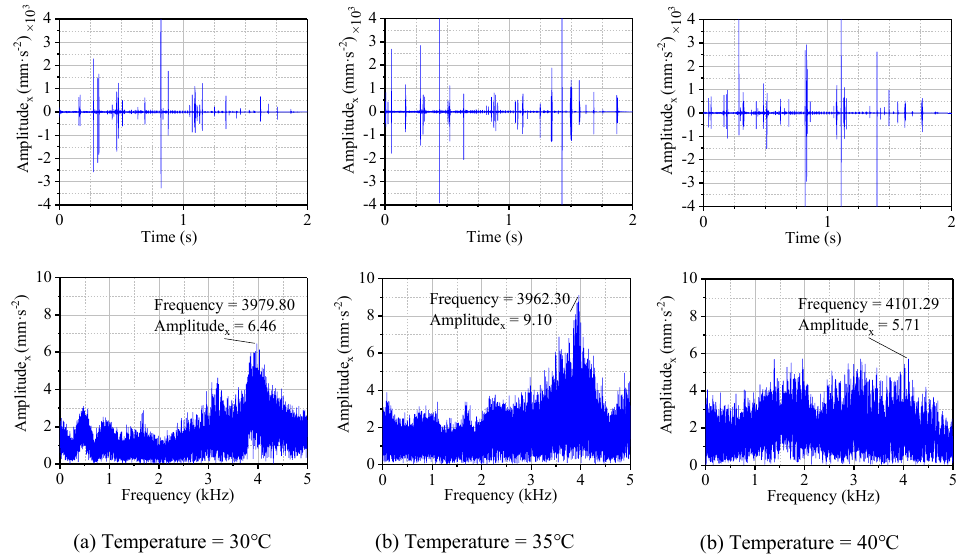
Figure 9. Displacement and frequency spectrum of N-502 under different temperatures with the μ 1 friction coefficient.